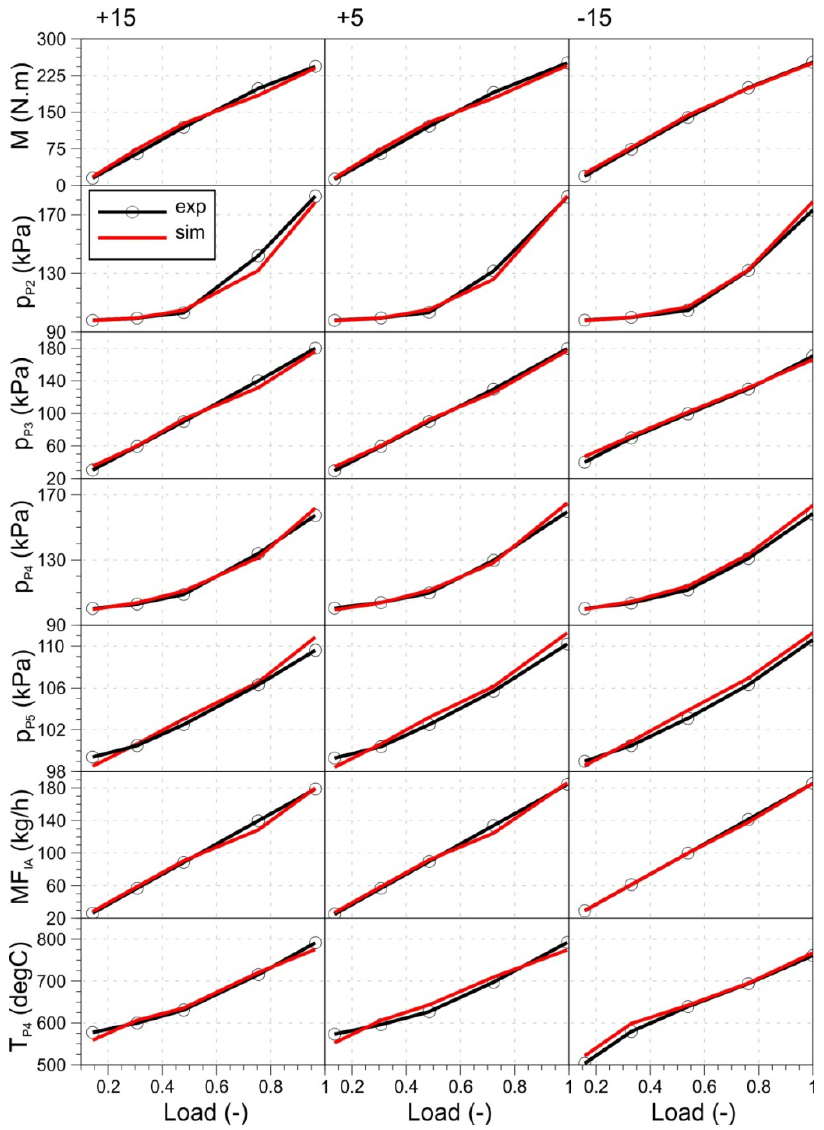
Figure A1. Comparison of simulated and measured torque (M), pressure in P2 (p